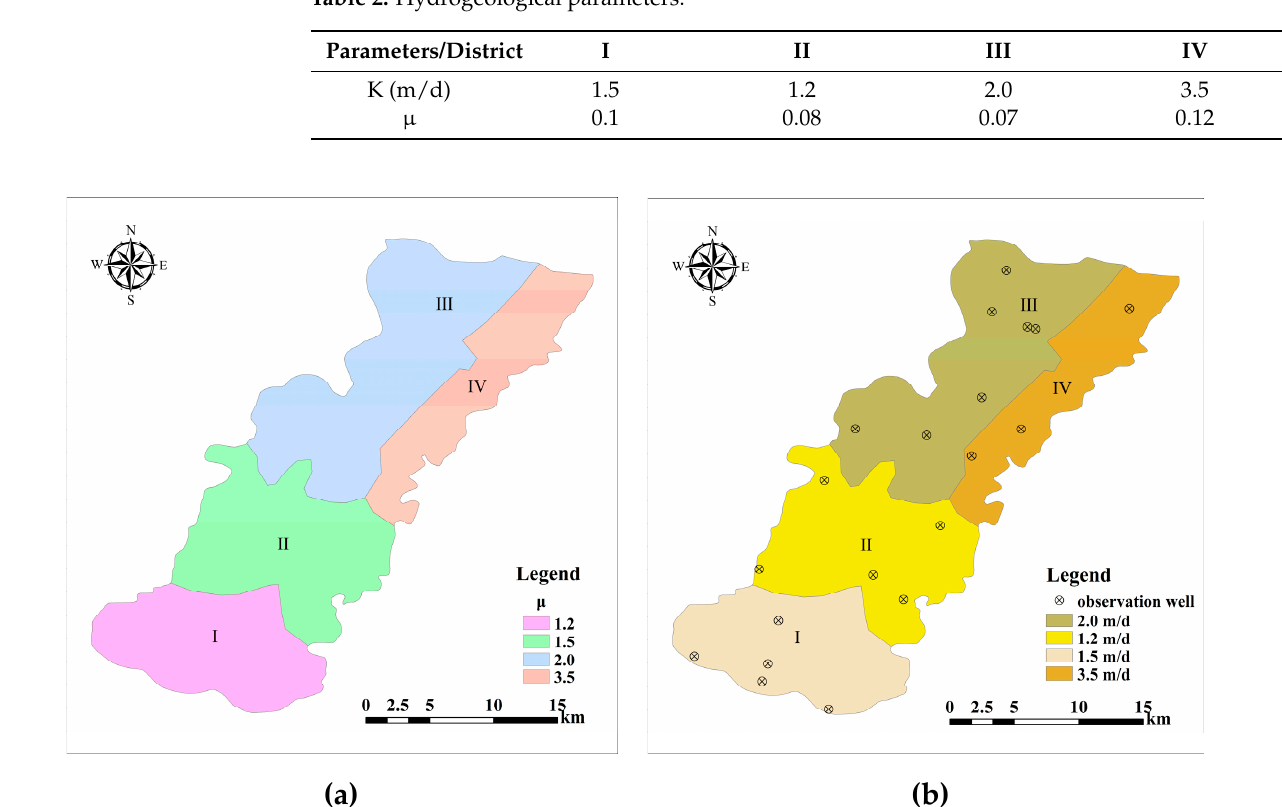
Figure 5. Permeability coefficient partition ( a ); hydraulic conductivity zoning and observation well locations in the study area ( b ).